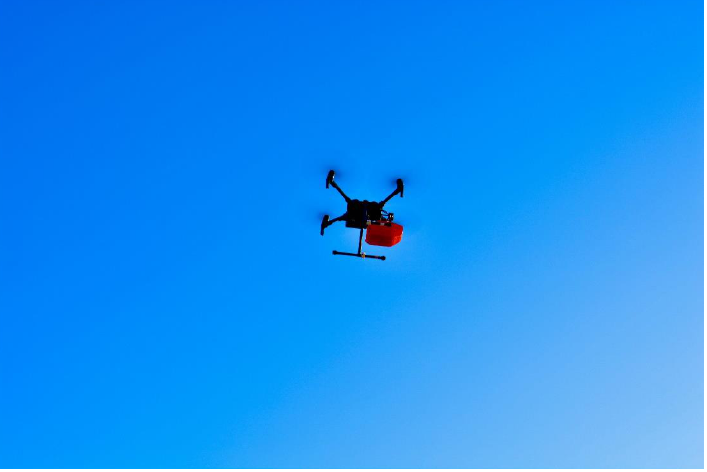
Figure 2. Image of the payload mounted on DJI Matrice 200 during a validation test.